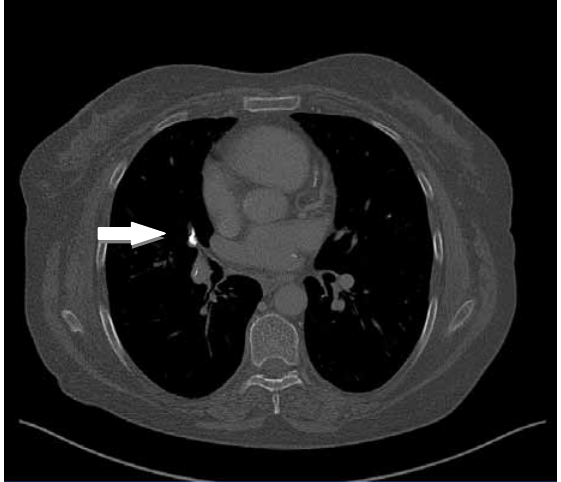
Figure 2. Native chest CT scan demonstrates a cement embolus in a peripheral right middle lobe pulmonary artery.